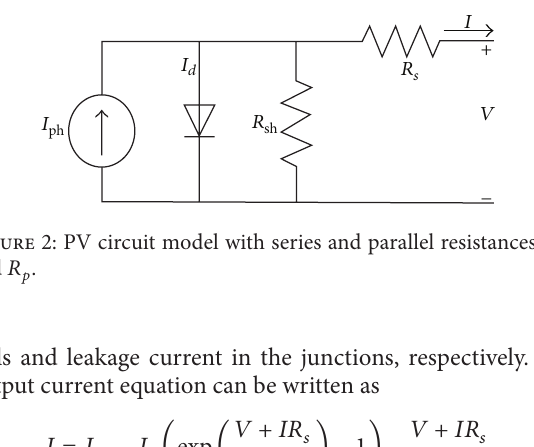
Figure 1: Ideal PV circuit model.